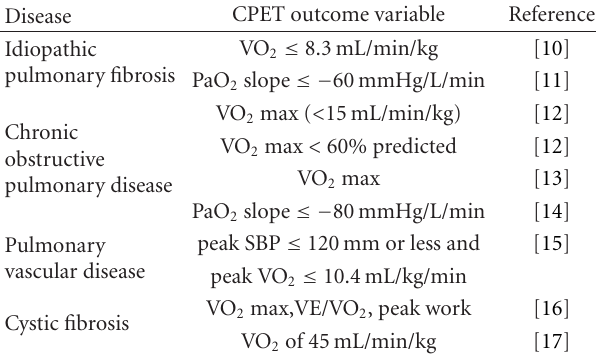
Table 2: CPET indicators that correlate with